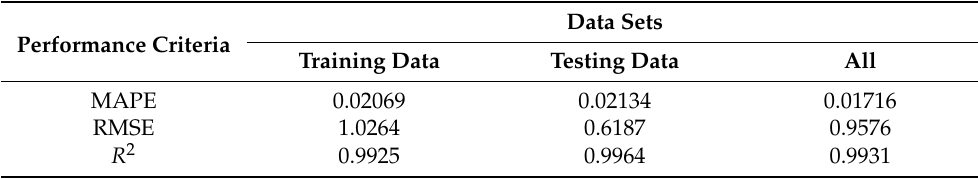
Table 1. The evaluation results for the predicted changes in the hardness of logs under di ff erent levels of decay and di ff erent moisture content conditions.